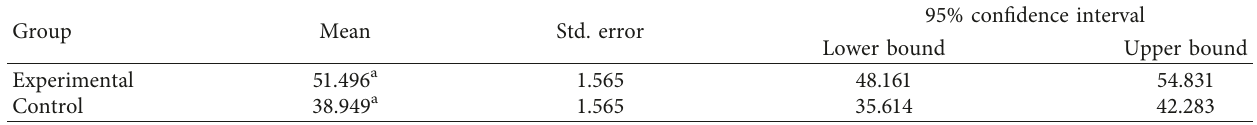
Table 4: Estimated marginal means.